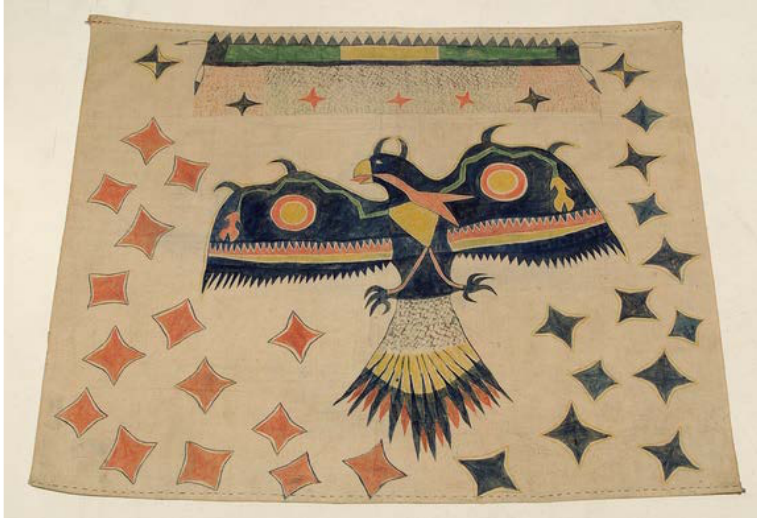
Figure 9. Painting on Muslin, attributed to Siyosapa (Hunkpapa/Yanktonai) Cotton muslin, paint, ink, 90.3 cm × 77 cm. Used by permission of the National Museum of the American Indian (023132). Photo by NMAI Photo Services.